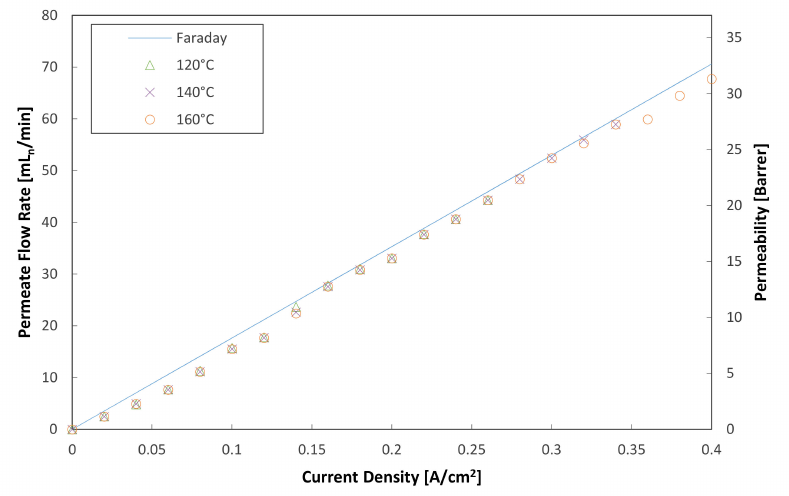
Figure 5. Theoretical and measured hydrogen permeate flow rates and hydrogen permeability (hydrogen flow rate = 100 mL n /min, 1